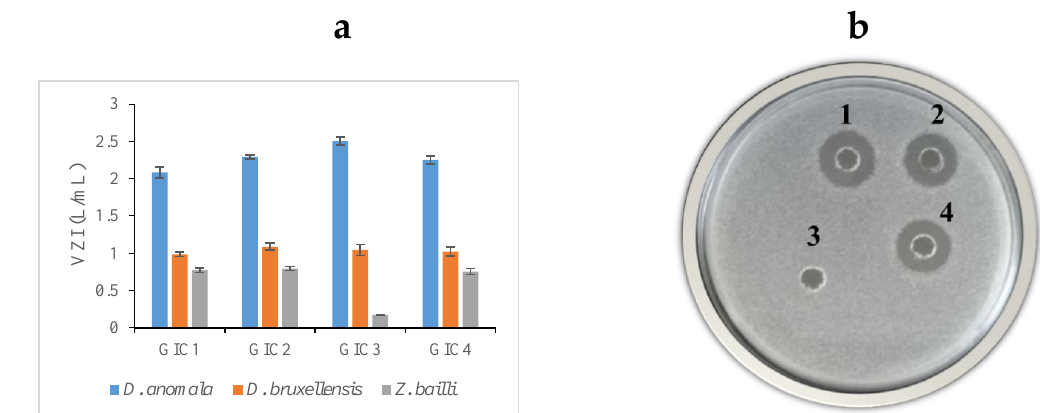
Figure 5. ( a ) Values of the volumetric zone of inhibition (VZI) obtained from mixtures of growth inhibition combinations (GICs) against spoilage yeasts ( Dekkera anomala, D. bruxellensis , and Zygosaccharomyces bailii ). (b) An example of a plate showing the VZI obtained for GIC1 ( C. pyralidae Y1117 and P. kluyveri Y1125) (1), GIC2 ( C. pyralidae Y1117 and P. kluyveri Y1164) (2), GIC3 ( P. kluyveri Y1125 and Pichia kluyveri Y1164) (3), and GIC4 ( C. pyralidae Y1117 , P. kluyveri Y1125, and P. kluyveri Y1164) (4) against Zygosaccharomyces bailli on grape pomace extract agar. The values presented are means of three replicates with the standard deviation ranging between 0.004 and 0.09.